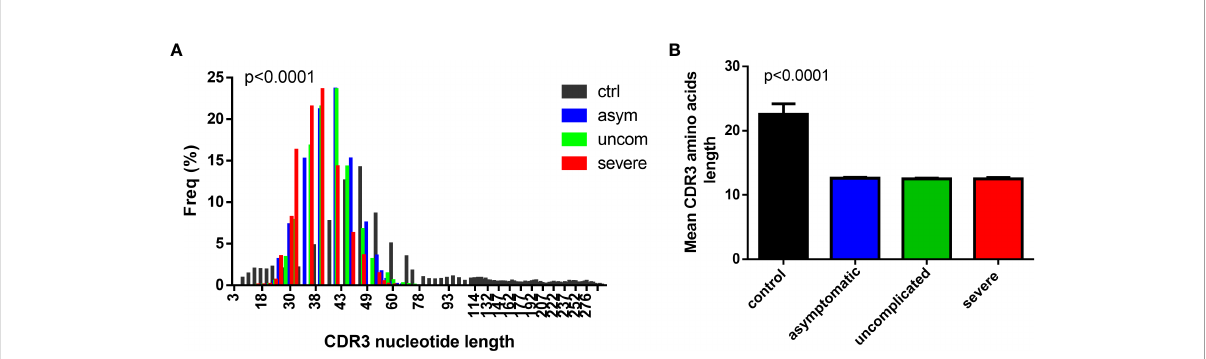
FIGURE 1 Decreased CDR3 length in P. falciparum infected group. A histogram plot showing the comparison of the (A) CDR3 length distribution for the (A) control (n=4), asymptomatic (n=7), uncomplicated (n=9) and severe groups (n=8), and (B) the mean CDR3 aa length for the controls, asymptomatic uncomplicated and the severe malaria